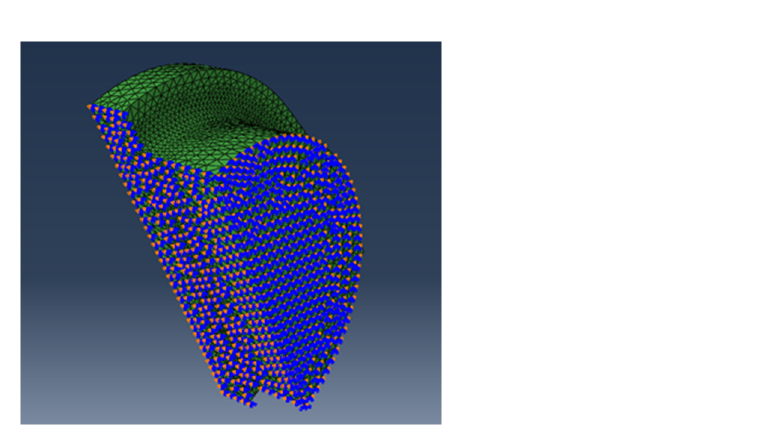
Figure 7. Displacement boundary conditions of the crankshaft for thermal-mechanical coupling analysis.